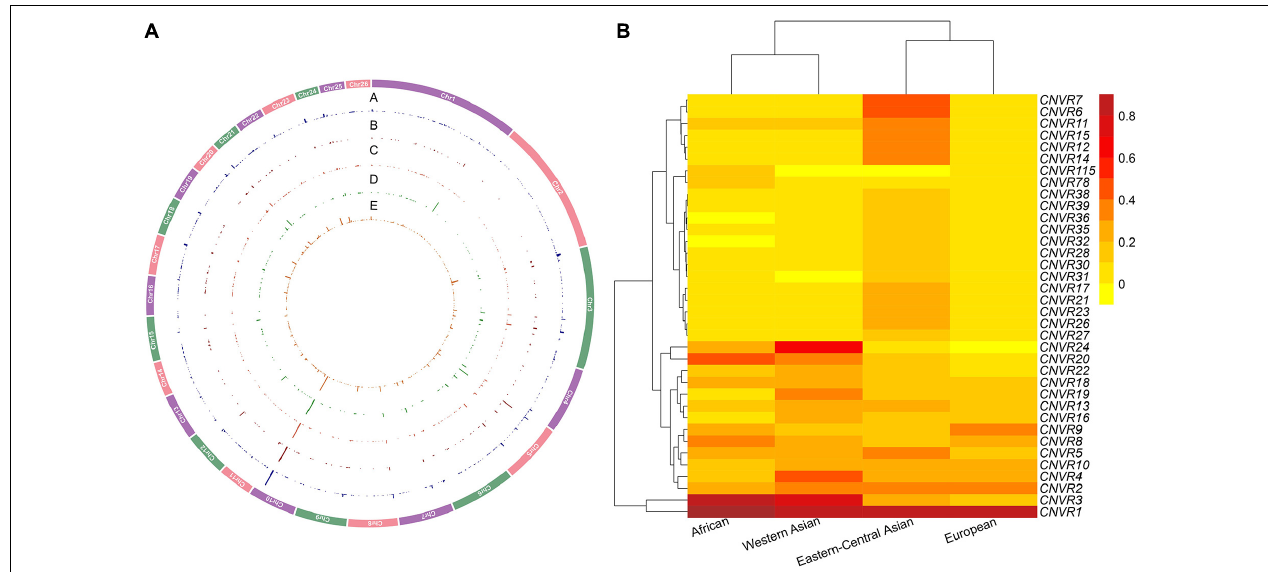
FIGURE 2 | (A) Genomic distribution and frequencies of copy number variation regions (CNVRs) on autosomes in the four genetic groups of domestic sheep populations. The tracks from outside to inside (A–E) are CNVRs shared across all the five groups: African, Eastern-Central Asian, European, and Western Asian populations. (B) CNVR frequency heatmap based on hierarchical clustering analysis for the top 5% of CNVRs (CNV events ≥ 2 CNV) in the four genetic groups of domestic sheep populations: African, Eastern-Central Asian, European, and Western Asian populations. The value is the number of CNVRs per individual (total of CNVRs/sample size based on population size in each